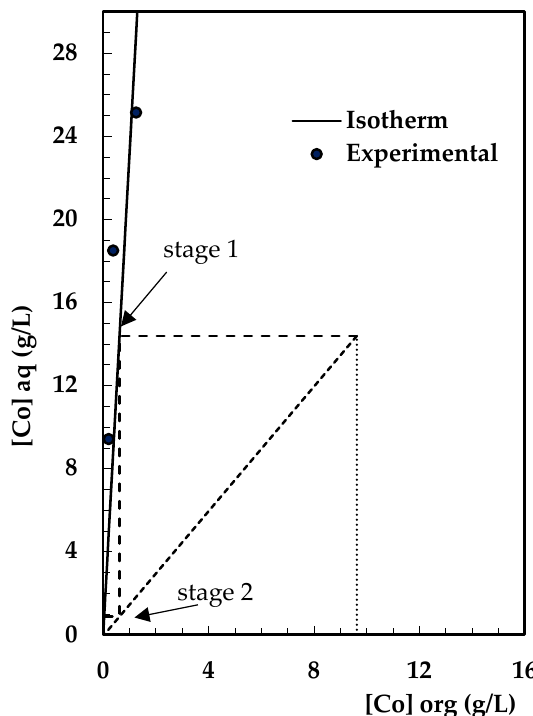
Figure 12. Stripping stages at O/A = 1.5, Xi = 9630 mg/L, Xf = 37.87 mg/L, [H 2 SO 4 ] = 1 mol/L, time = 4 min, and temperature = 22 ± 1 °C.